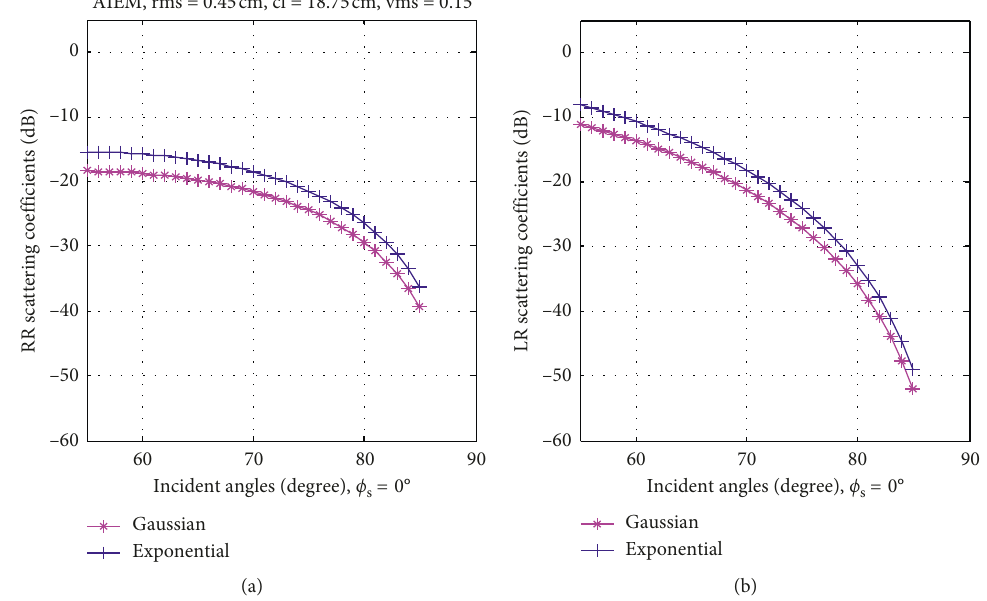
Figure 6: Correlation functions on the RR and LR